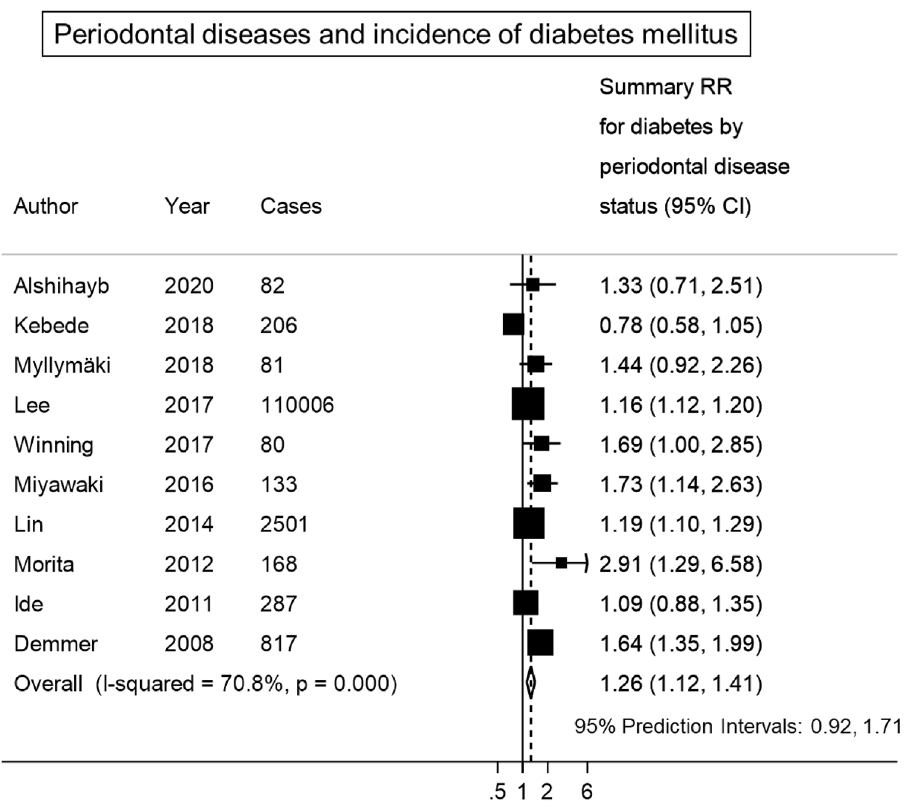
Figure 1. Meta-analysis of periodontal disease and incidence of diabetes